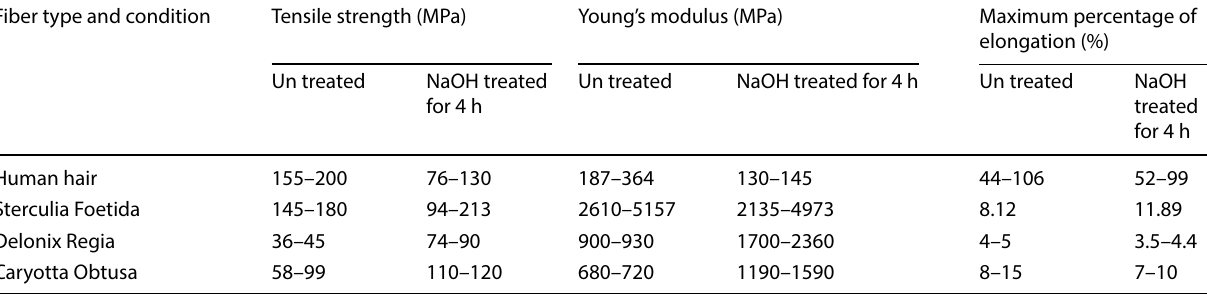
Table 7 Tensile properties of untreated and treated natural fibers Fiber type and